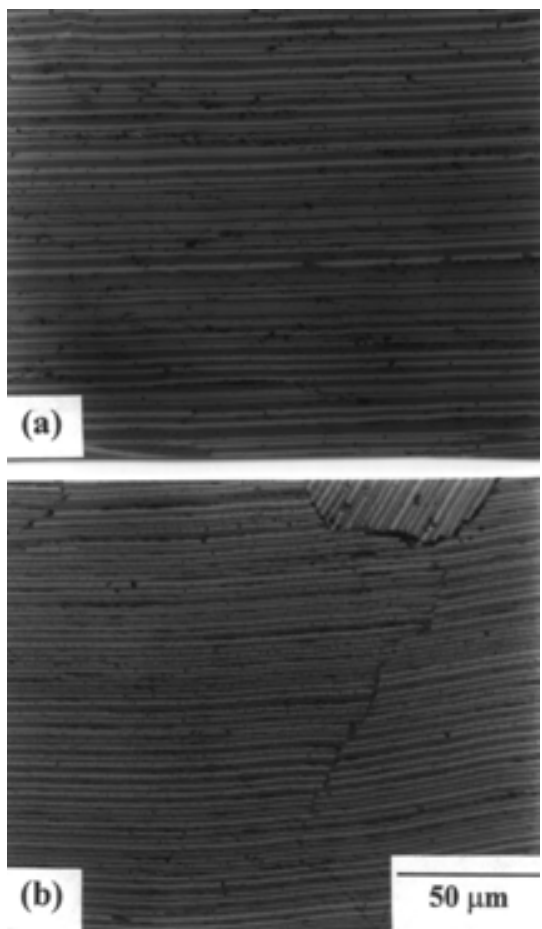
Figure 6. Typical microstructures obtained from directionally solidified Sn-Se eutectic samples: (a) longitudinal view; (b) cross view.